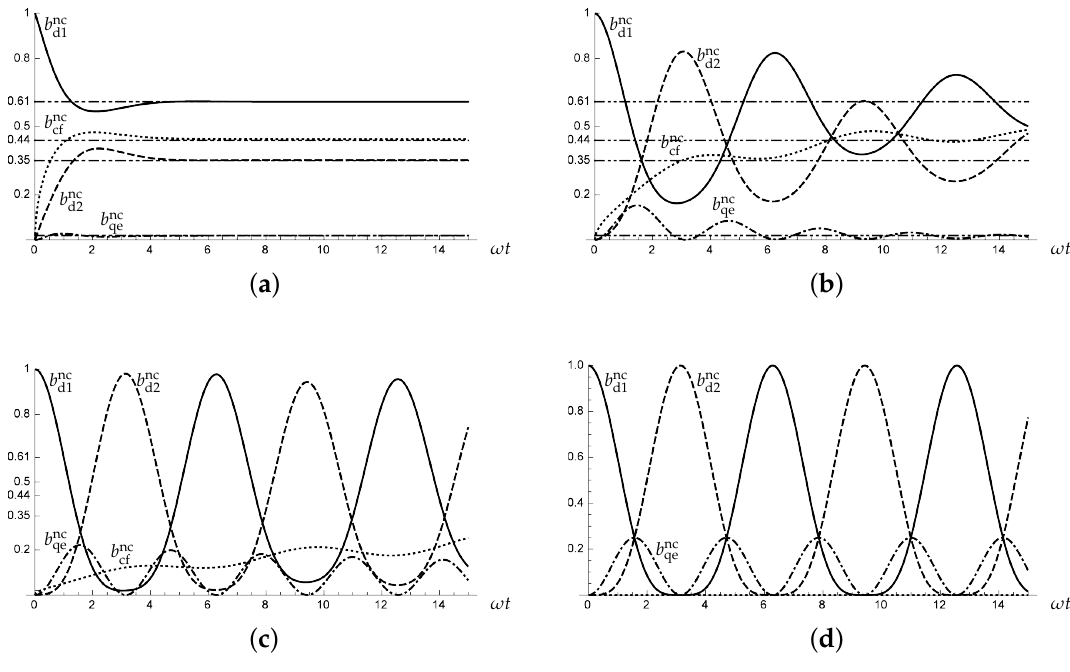
( ----- ) , b nc ( --- ) , b nc ( ) , and b nc ( - - ) , in dissipative qe d1 d2 cf ··· · , b nc , b nc , and b nc - ) in parts ( a , b ) represent the asymptotes of the b nc qe d1 cf d2 ·· vanishes identically. cf , b nc , and b nc show a kind of “classical-quantum crossover” oscillation. qe d1 d2